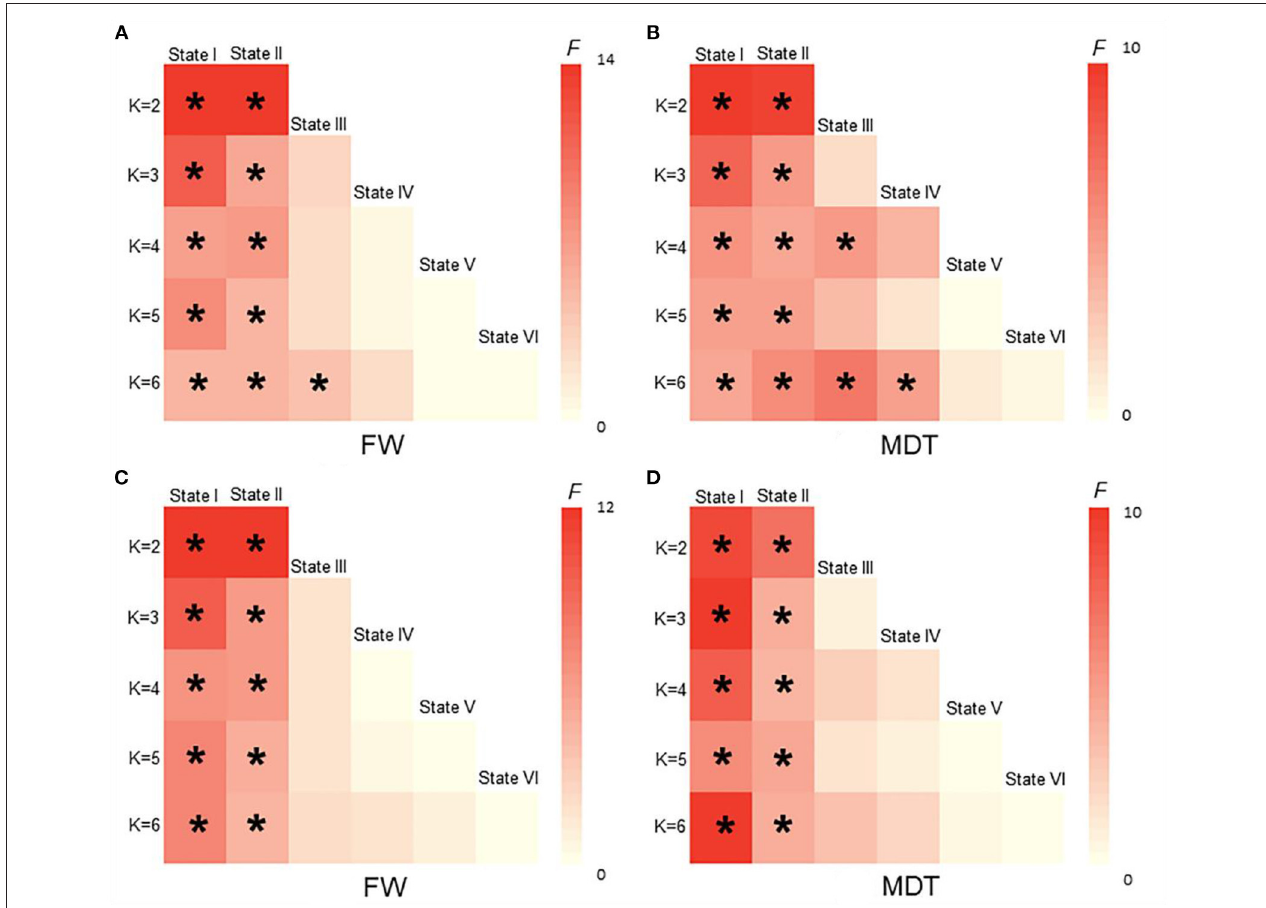
FIGURE 6 | The difference of FW and MDT in different K values among HCs, CSVD, CSVD-CU and SVCI. ( K = 2, K = 3, K = 4, K = 5, K = 6). (A) Comparison of FW between HCs and CSVD by GLM. (B) Comparison of MDT between HCs and CSVD by GLM. (C) Comparison of FW among HCs, CSVD-CU and SVCI by GLM. (D) Comparison of MDT among HCs, CSVD-CU and SVCI by GLM. GLM, general linear model; FW, fractional windows; MDT, mean dwell time. * P <